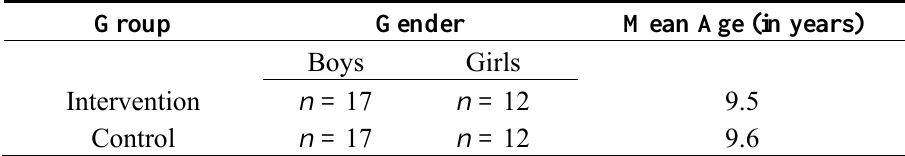
Table 1. Description of